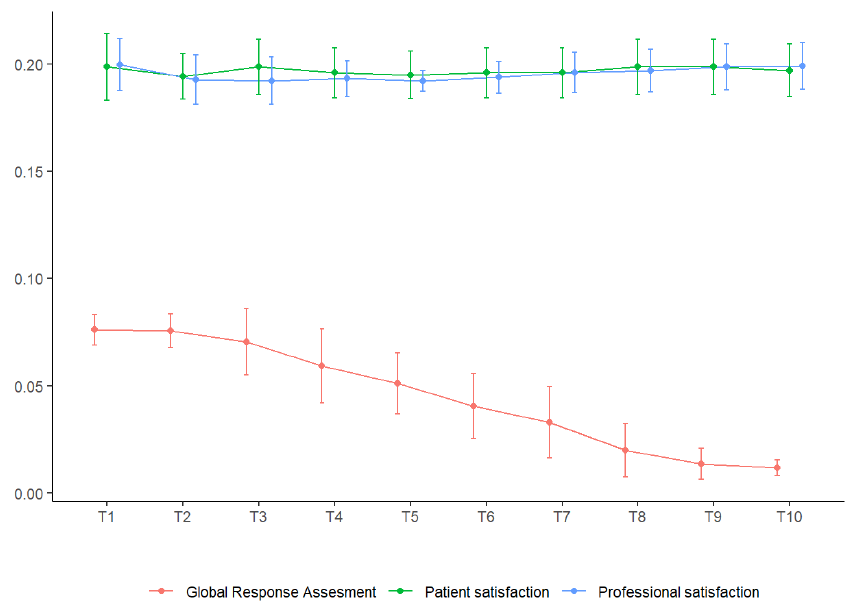
Figure 3. Subjective perception (standardized mean and standard deviation error bars).